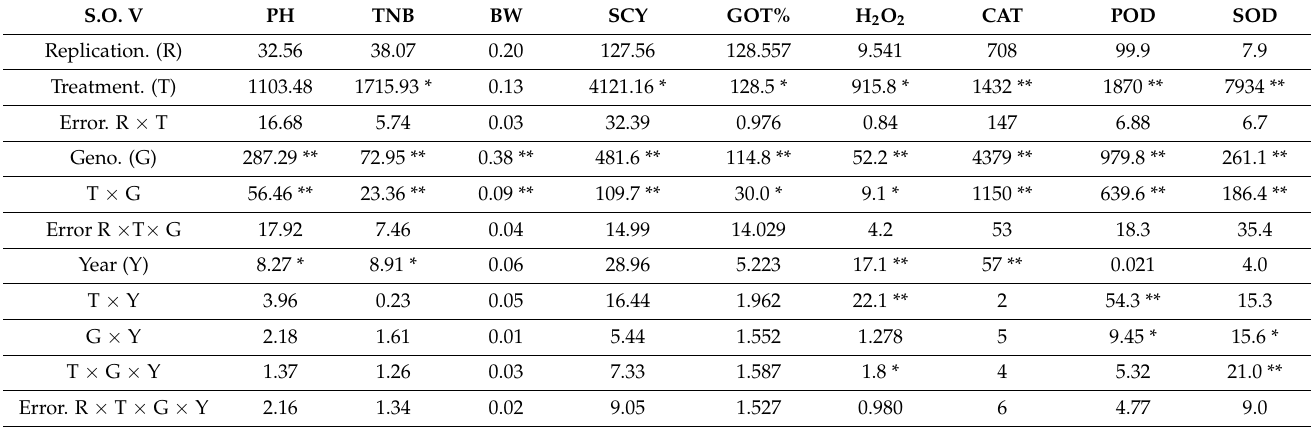
Table 2. Mean squares value from ANOVA of Heat × Year × Genotypes interaction.